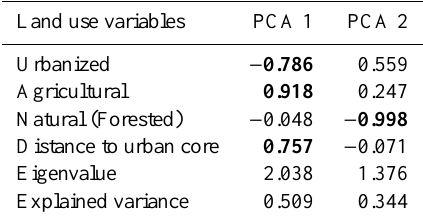
Table 2. Factor loadings of land use variables for the first two Fac- tors derived from principal component analysis. In bold the land use categories significantly associated to each PCA